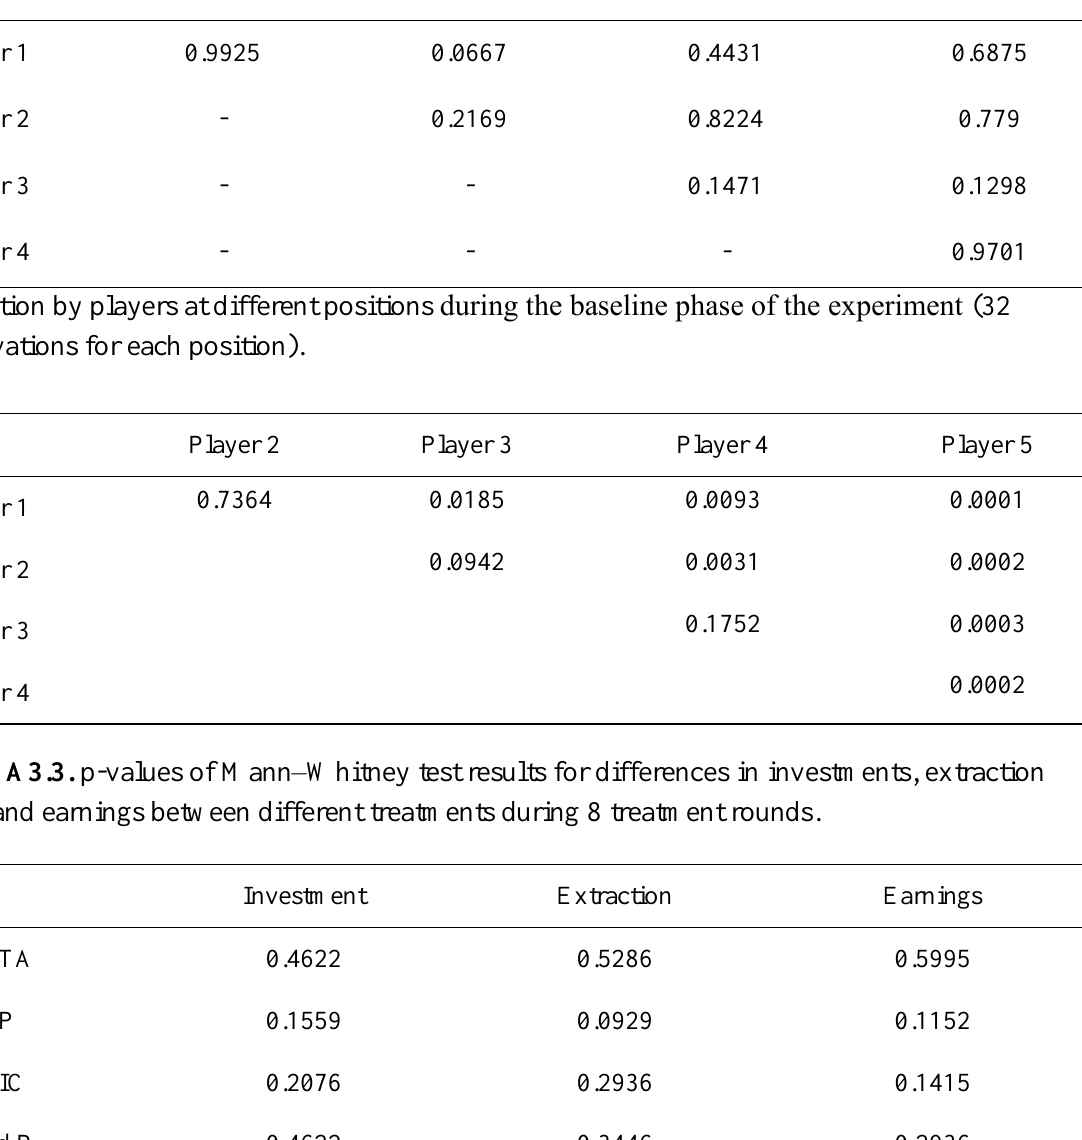
Table A3.1. p-values of two-tailed Wilcoxon Matched-Pairs Signed-Ranks Test statistics for the number of tokens invested for the provision of CPR by players at different positions during the baseline phase of the experiment (32 observations for each position).